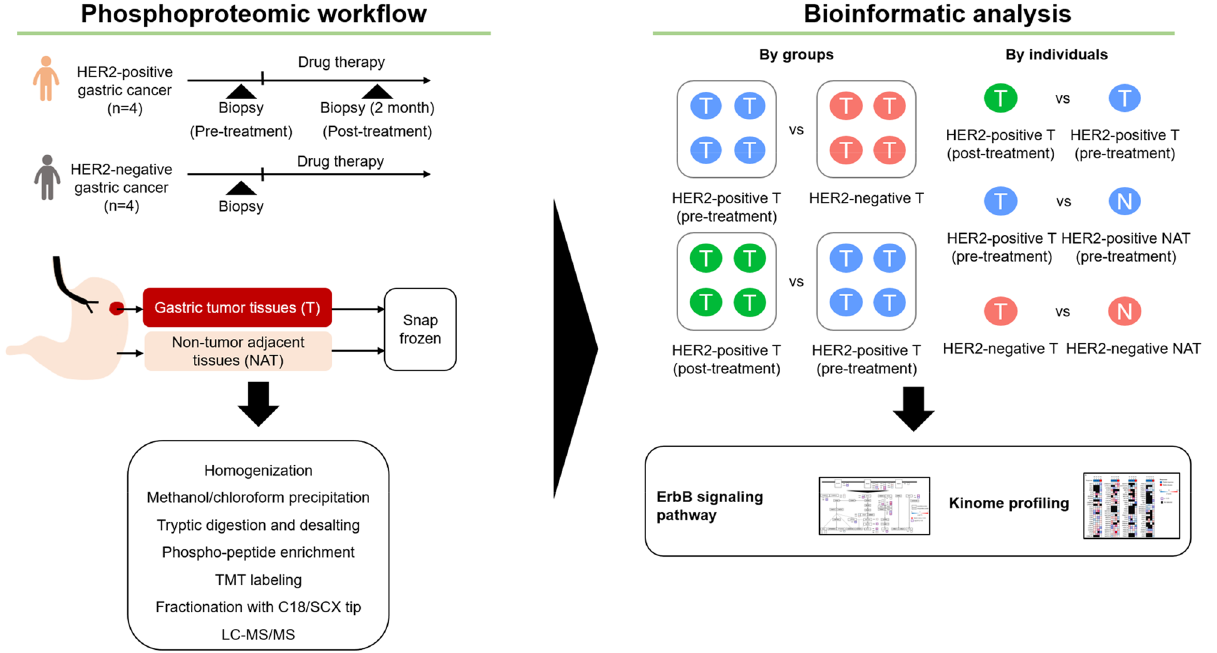
Figure 1. Schematic diagram of the quantitative phosphoproteomic analysis in this study. Using endoscopic procedures, tumor tissues and non-tumor adjacent tissues were collected from four patients with HER2-positive gastric cancer (before and after drug therapy [trastsuzumab-containing therapy]) and four patients with HER2- negative gastric cancer. Those specimens were subject to sample preparation for quantitative phosphoproteomic analysis. Using phosphoproteomic data, bioinformatics analyses were conducted to evaluate molecular differences by groups and by individuals.